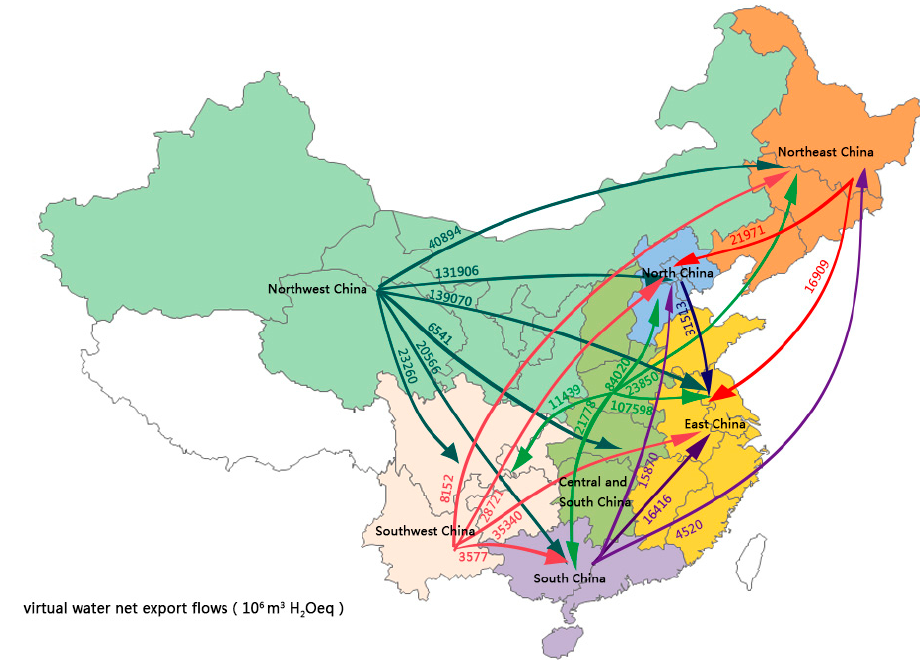
Figure 3. Detailed Impact-Oriented agricultural virtual water net export flows.